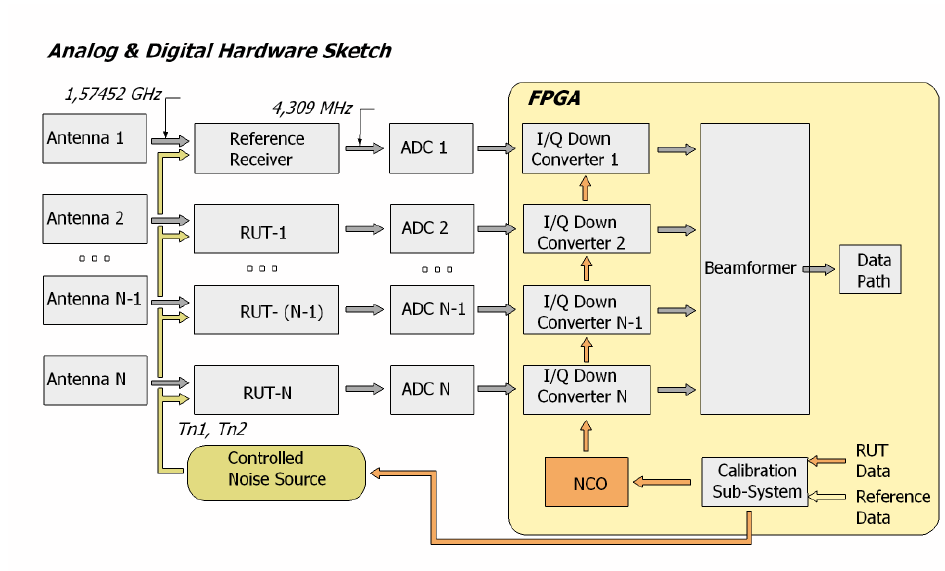
Figure 8. Analog and digital hardware block diagram. Note that each I/Q down-conveter has its own Numerical Controlled Oscillator (NCO).